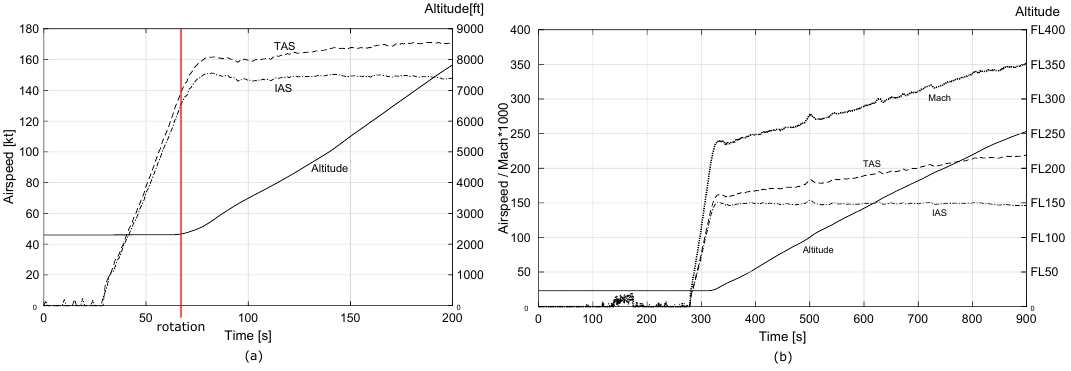
Figure 3. ( a ) NS872 take-off and ( b ) initial climb performance for Mission